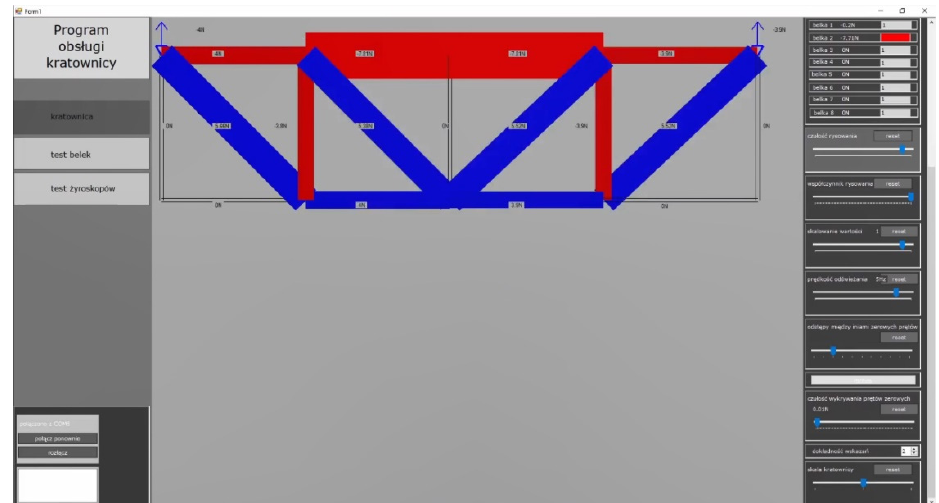
Figure 7. Visual Studio interface.